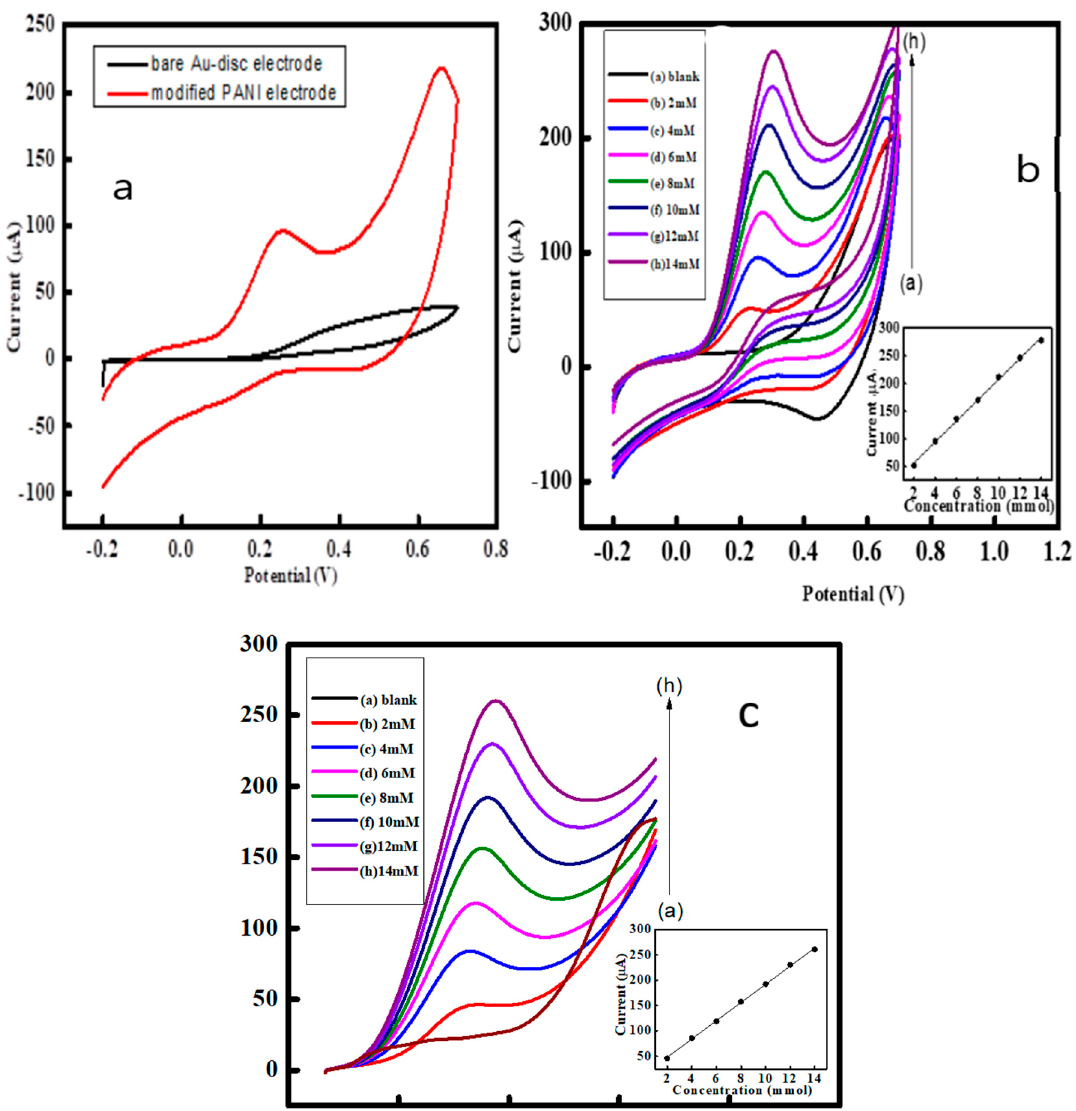
Figure 8. ( a ) Electro-chemical response of bare Au disc and PANI modified electrode towards 4 mM AA in 0.1 M PBS (pH = 4) at scan rate of 50 mV s − 1 . ( b ) Cyclic voltammograms of PANI modified electrode recorded in the presence of various AA concentrations (2–14 mM) in 0.1 M PBS (pH = 4) at scan rate of 50 mV s − 1 . ( c ) Linear sweep voltammetry of the PANI modified electrode in the presence of various AA concentrations (2–14 mM in 0.1 M PBS (pH = 4)) at scan rate of 50 mV s − 1